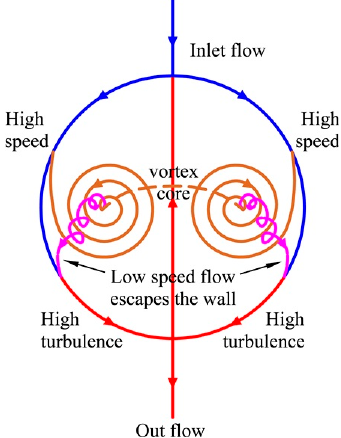
Figure 18. Flow diagram inside the